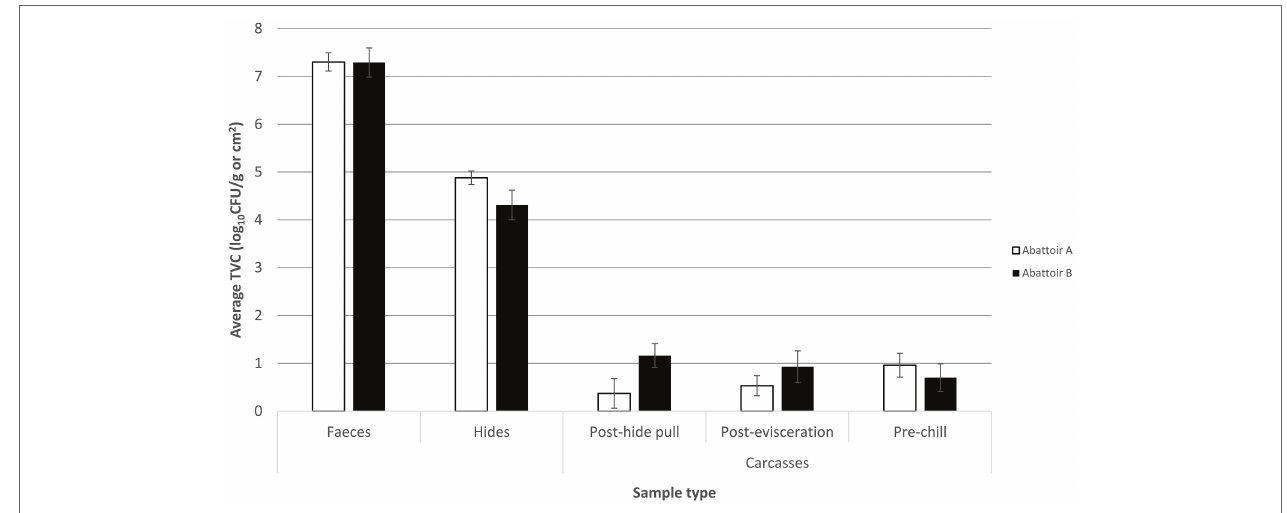
FIGURE 1 | Mean total viable count (TVC) of fecal, hide, post-hide pull, post-evisceration, and pre-chill carcase samples collected from the slaughter floor of an integrated (abattoir A) and a fragmented (abattoir B) Australian beef supply chain. Mean TVCs of fecal samples are reported in log 10 CFU/g with the hide and carcase samples reported in log 10 CFU/cm 2 . Each column represents the mean of X samples with error bars representing the standard deviation from the